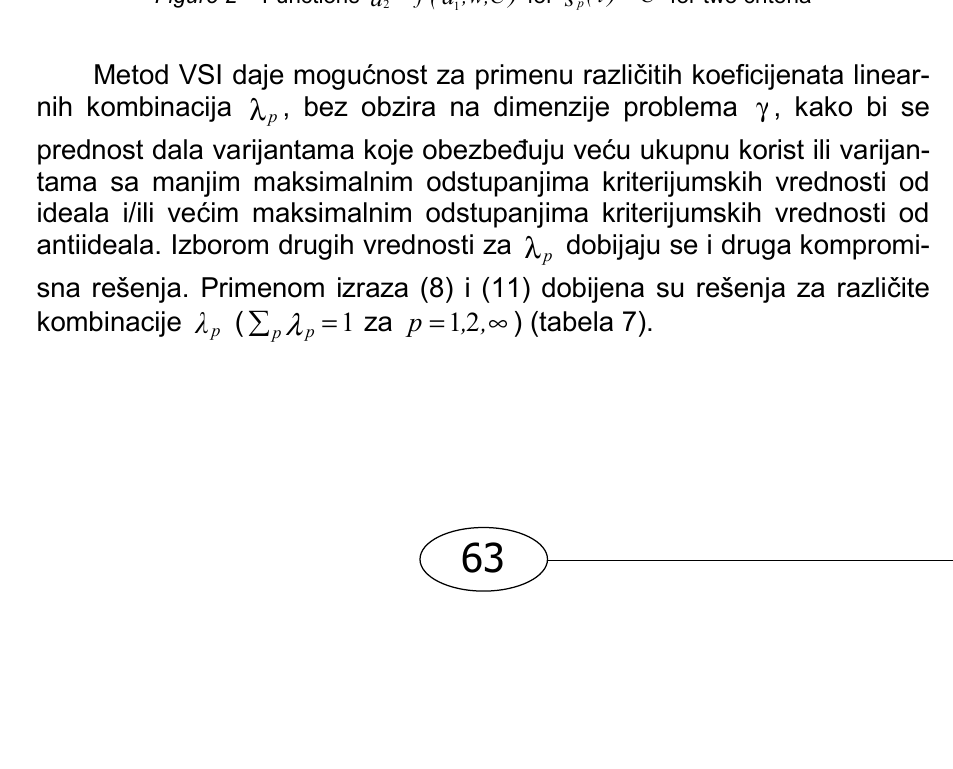
Рис . 2 – Функция C)i( s Figure 2 – Functions )C,w,f a(a